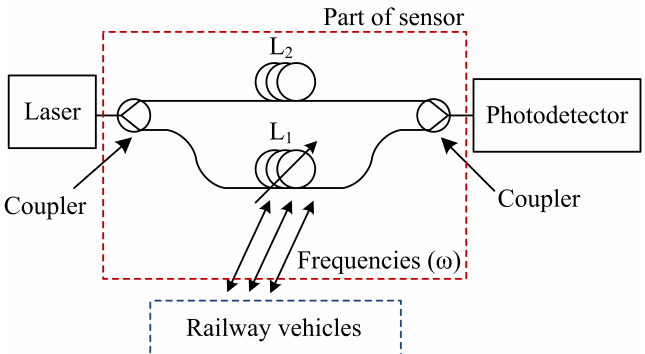
Figure 1. A simplified scheme of the interferometric sensor based on the Mach–Zehnder